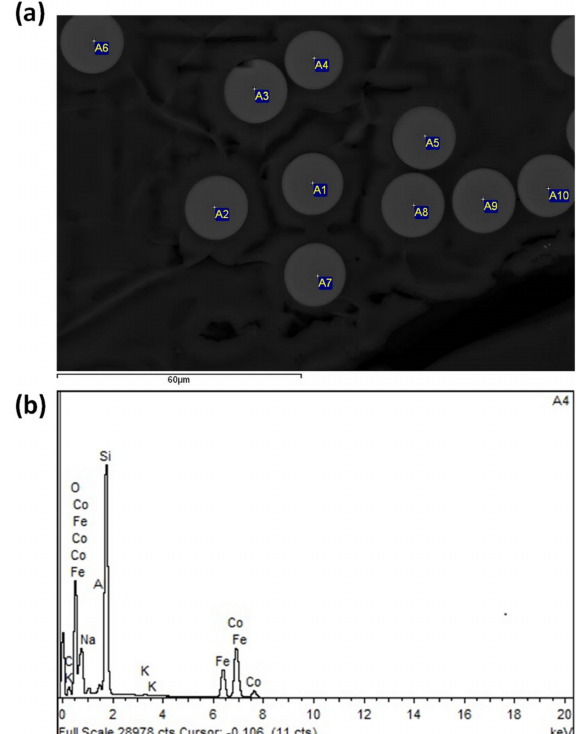
Figure 1. The cross section of Co 2 FeSi G-CMMWs images ( a ) and the chemical composition spectra of EDX at one of the points ( b